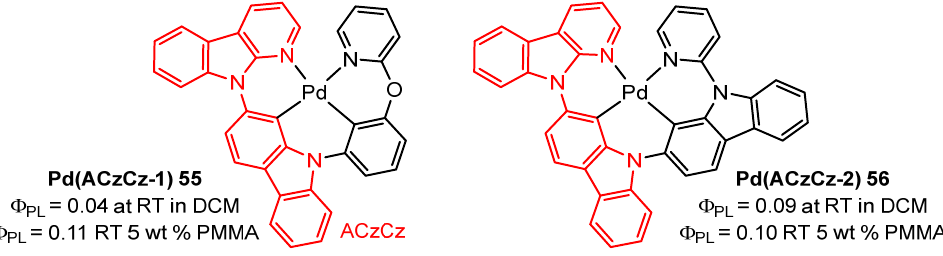
Figure 19. Chemical structures of ACzCz-based tetradentate Pd(II) complexes. ACz, aza carbazolyl group. Adapted from [83]. Further work of the same group [84] also focused on the synthesis of tetradentate Pd(II) complexes 57 – 69 with deep-blue phosphorescence. The heterocyclic moiety (Figure 20) plays a crucial role in efficiently regulating the triplet-state properties. Modifying the ligands with isoelectronic imidazole 63 , oxazole 64 , and thiazole rings 65 or a pyridine ring 66 destabilizes the 3 LE state and results in sky-blue to yellow materials with an admixture of 3 MLCT/ 3 ILCT states. Additionally, the Pd(II) complexes are strongly emissive in various matrices and achieve quantum efficiencies of up to 51%. In line with these results, tetradentate Pd(II) complexes 67 – 69 containing fused 5/6/6 metallocycles (Figure 20) from benzo[d]imidazole Pd(pbiz) 67 , benzo[d]oxazole Pd(pboz) 68 , or benzo[d]thiazole Pd(pbthz) 69 were also obtained